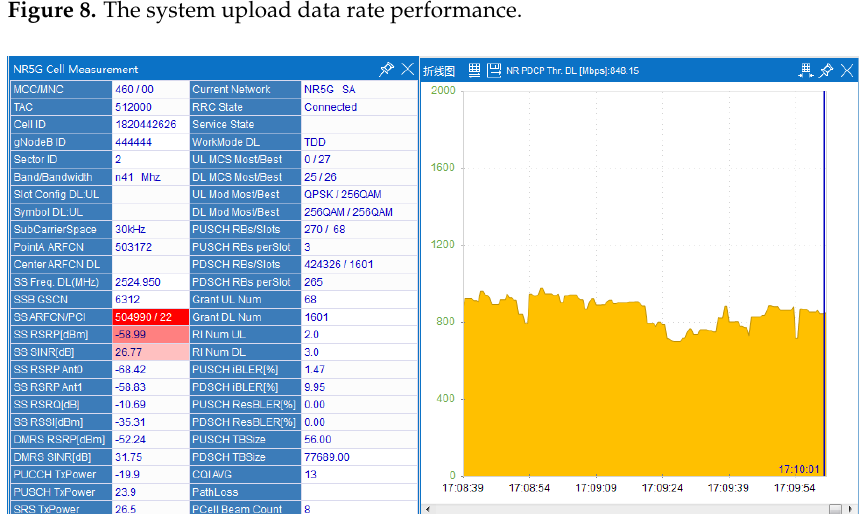
Figure 9. The system download data rate performance.